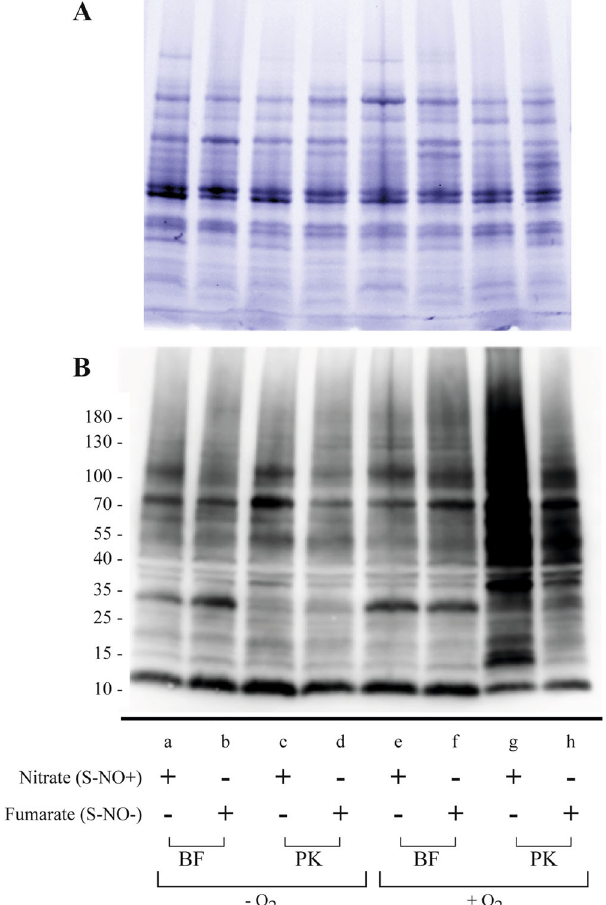
Fig. 3 Protein S- nitrosylation pro fi les in E. coli planktonic (PK) or bio fi lm (BF) conditions. Cultures were grown under aerobiosis ( + O 2 ) or anaerobiosis ( − O 2 ) and under S- nitrosylating conditions with excess 10 mM nitrate (S-NO + ), or non- S- nitrosylating condition supplemented with 10 mM fumarate (S-NO − ). Proteins were extracted, processed with the biotin-switch method (see Fig. 1) and analyzed by western blot. A Total protein extracts visualized with Stain-free fl uorescent detection; B S-NO proteins visualized by western blot followed by immunodetection using avidin-HRP